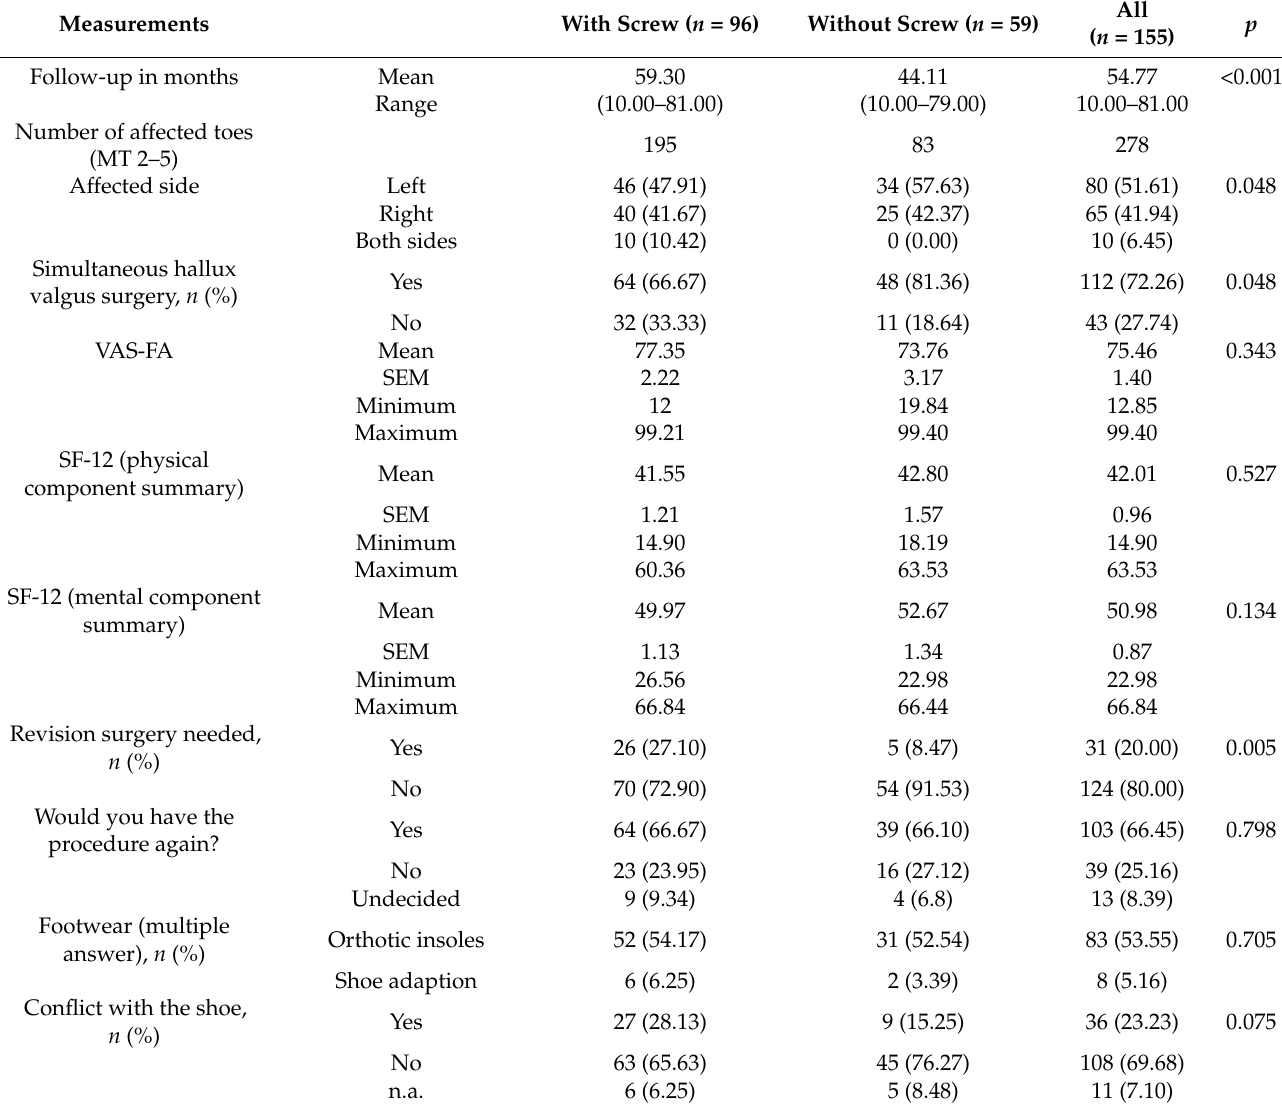
Table 2. Clinical outcomes according to treatment, based on the number of treated